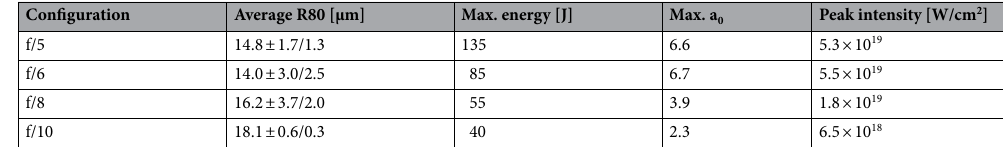
Table 1. Properties of injection-plane apodizers used for this work. The maximum energy is given for operation at best compression, i.e. duration of 700 ± 100 fs. The maximum a 0 value given in column four and the peak intensity given in column five are the maximum values calculated from the laser energy, spot size, and pulse duration measured during this course of experiments.